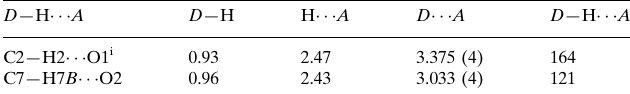
Hydrogen-bond geometry (A˚ , (cid:2)